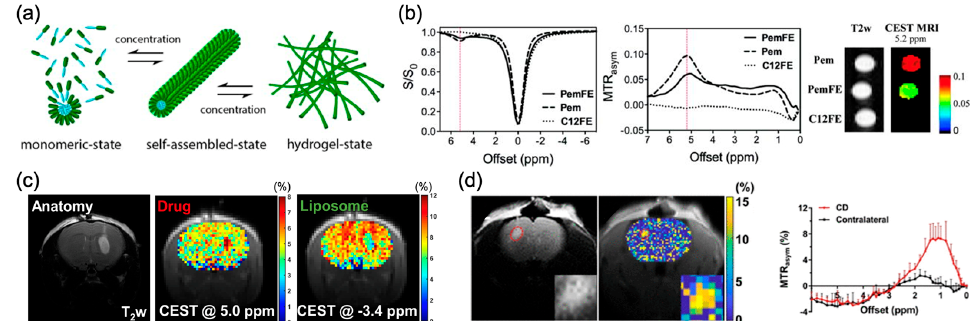
Figure 5. ( a ) Schematic illustration of the self-assembly of PemFE monomers into filamentous nanostructures that can further entangle into a 3D network for the formation of self-supporting hydrogels under suitable conditions (pH, concentration, and ionic strength). ( b ) Z-spectra, MTR asym plots, and CEST contrast maps of PemFE (solid), Pem (dashed), and C12FE (dotted) showing CEST peaks at 5.2 ppm. ( c ) T2-weighted image and CEST images (5.0 ppm and − 3.4 ppm) of drug barbituric acid (BA) loaded liposomal hydrogels in a mouse brain. ( d ) T2-weighted image, MTR aysm image at 1.1 ppm, and the average MTR aysm spectra of CD hydrogel in a mouse brain. Pem: Pemetrexed. Reproduced with permission from [159], American Chemical Society, 2017; [166], Ivysrping Inter- national Publisher, 2020; [167], American Chemical Society, 2021.